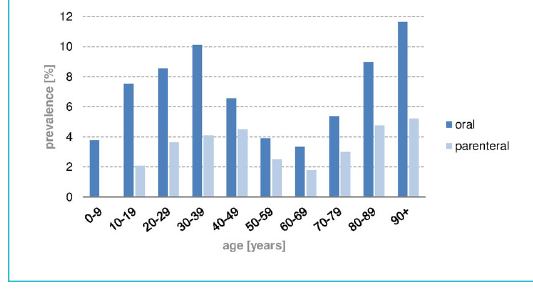
Figure 1: Prevalence of iron substitution in different age groups in Switzerland and the UK, 2012 to 2014.